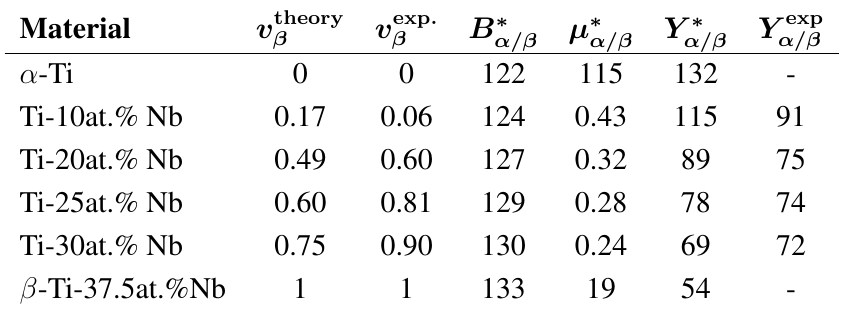
Theoretically predicted polycrystalline integral elastic parameters and phase- composition of Ti-Nb composites with selected Nb concentrations (of actually cast samples) together with the experimental